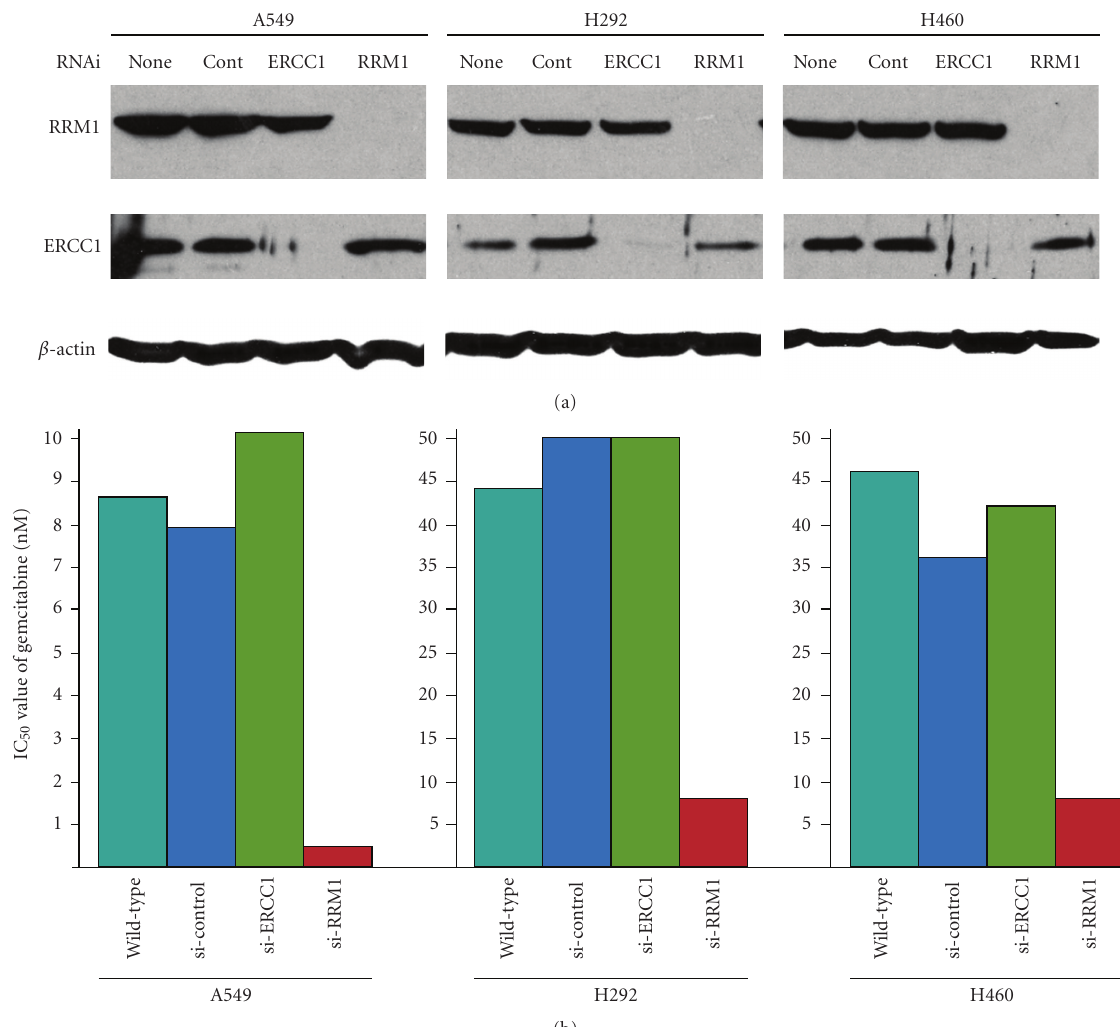
Figure 2: Knock-down of RRM1 and ERCC1 expression in three NSCLC cell lines by RNA interference and impact on gemcitabine e ffi cacy. (a) Western blots showing that RRM1-specific siRNA reduced RRM1 protein expression to undetectable levels, while random control and ERCC1-specific siRNAs did not a ff ect RRM1 expression. Likewise, ERCC1-specific siRNA reduced ERCC1 protein expression to undetectable levels, while random control and RRM1-specific siRNAs did not a ff ect ERCC1 expression. (b) IC50 values of gemcitabine cytotoxicity in cell lines A549, H292, and H460. Wt, wild-type cell lines; si-control, cell lines transfected with nonspecific siRNA; si-ERCC1; cell lines transfected with ERCC1-specific siRNA; si-RRM1, cell lines transfected with RRM1-specific